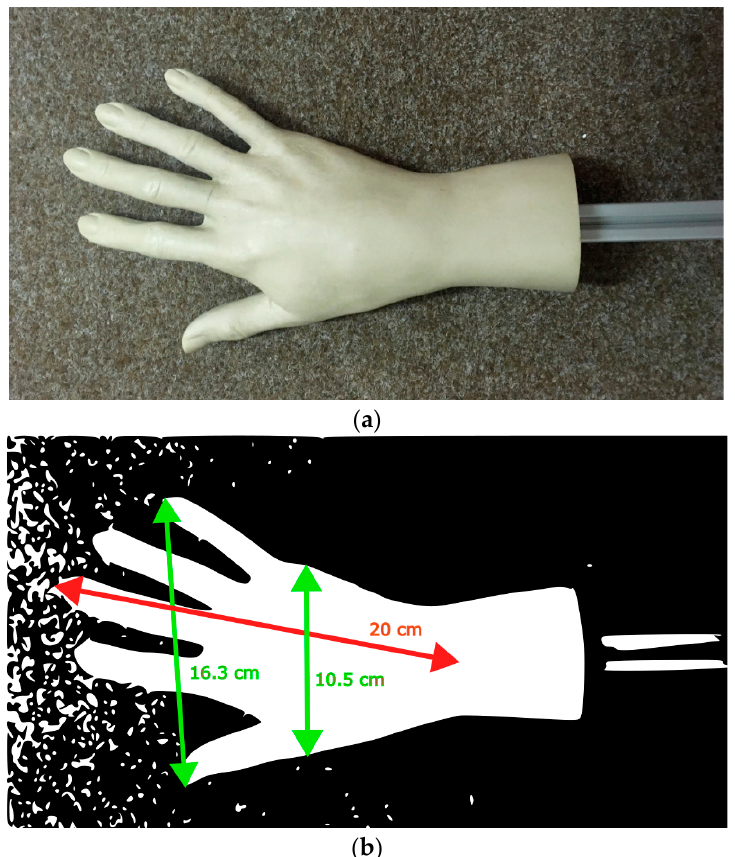
Figure 5. (a) Final replica of the operator’s right hand. ( b ) Dimensions of the replica. Figure 5. ( a ) Final replica of the operator’s right hand. ( b ) Dimensions of the